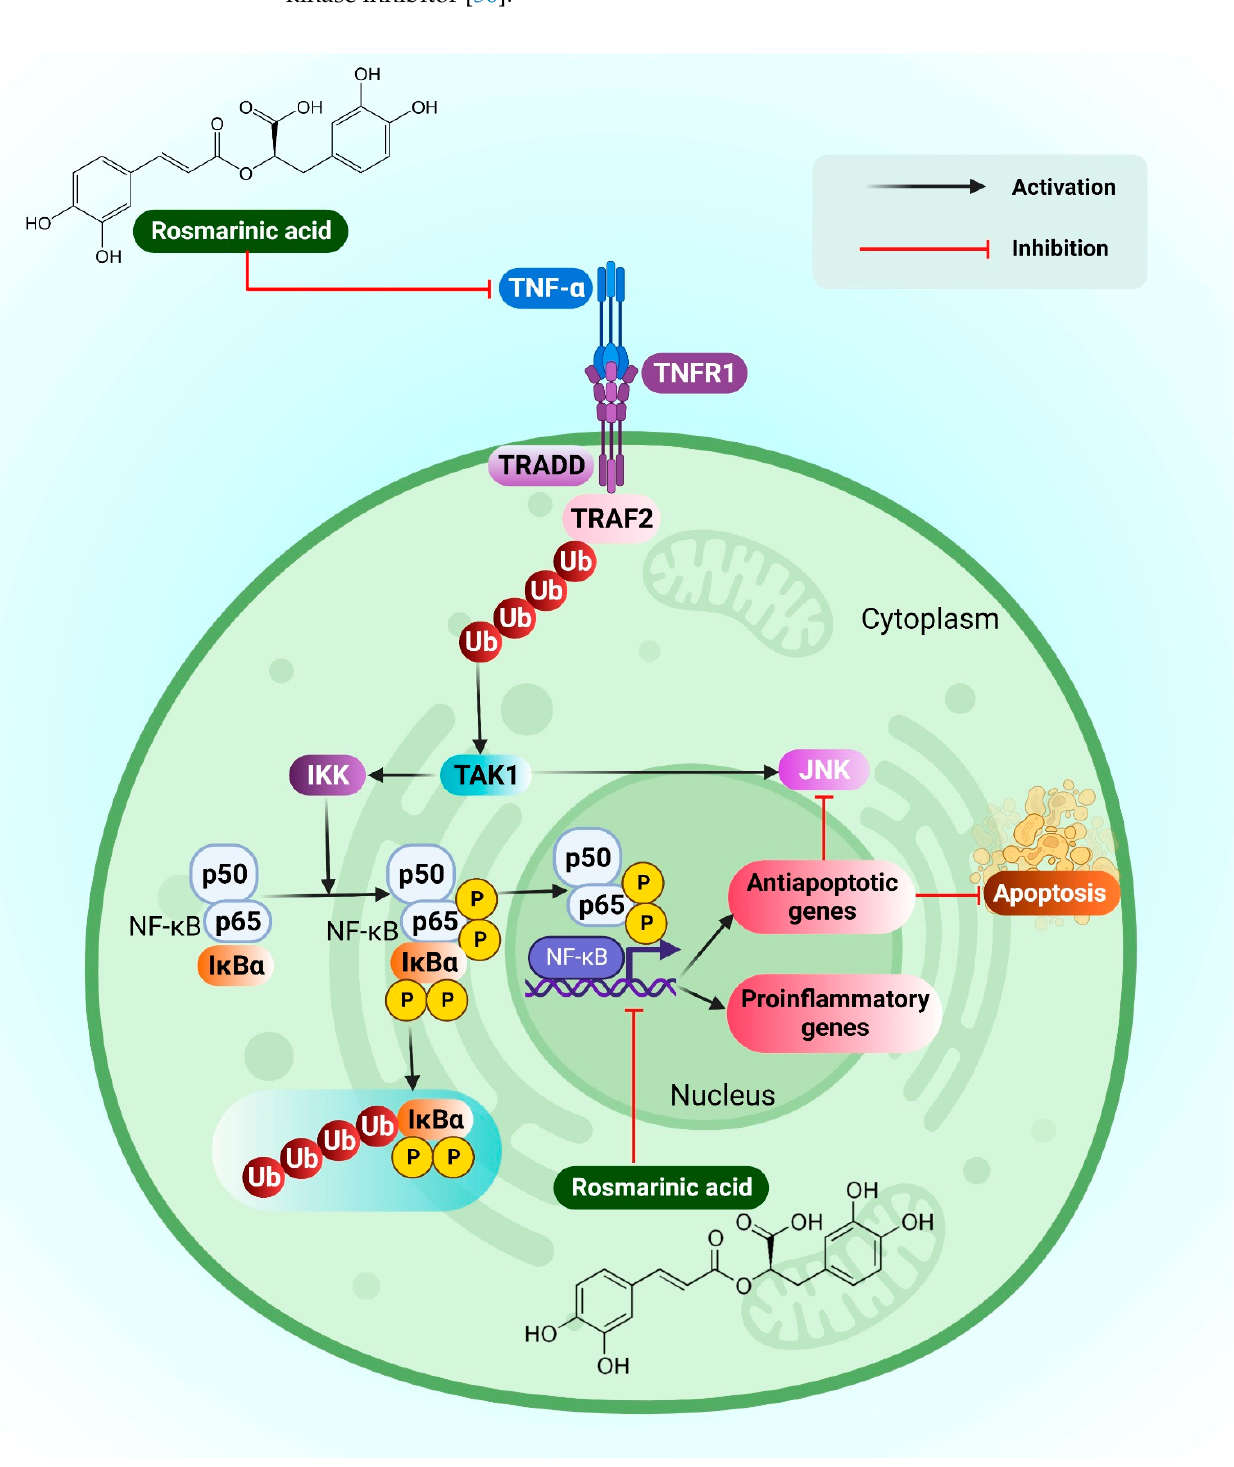
Figure 4. Figure depicting molecular mechanism of rosmarinic acidon A 549 (Lung cancer cell lines) through inhibition of NF-k β .